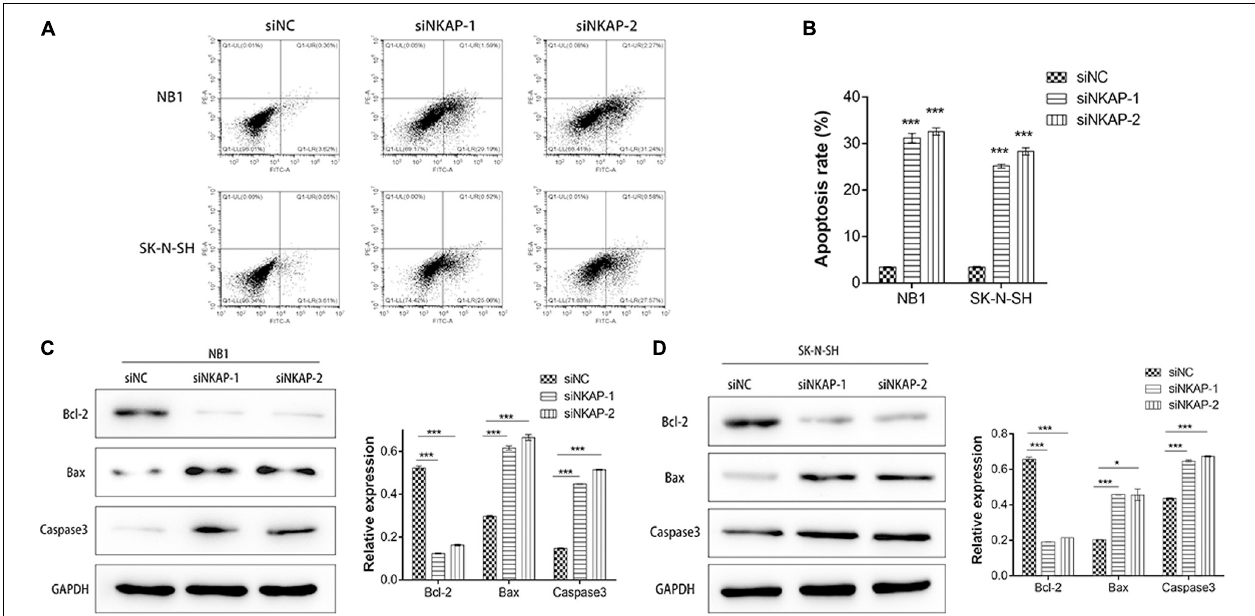
FIGURE 4 | Knockdown of NKAP promotes apoptosis of neuroblastoma cells. (A,B) Effect of NKAP low expression on apoptosis in NB1 and SK-N-SH cells was examined by flow cytometry assay using an Annexin V-FITC Apoptosis Detection Kit. Apoptosis-associated proteins of Bcl-2, Bax, and Caspase3 were examined by Western blot in NB1 cells (C) and SK-N-SH cells (D) after transfected with siNC, siNKAP-1, and siNKAP-2. *** P < 0.001, * P <